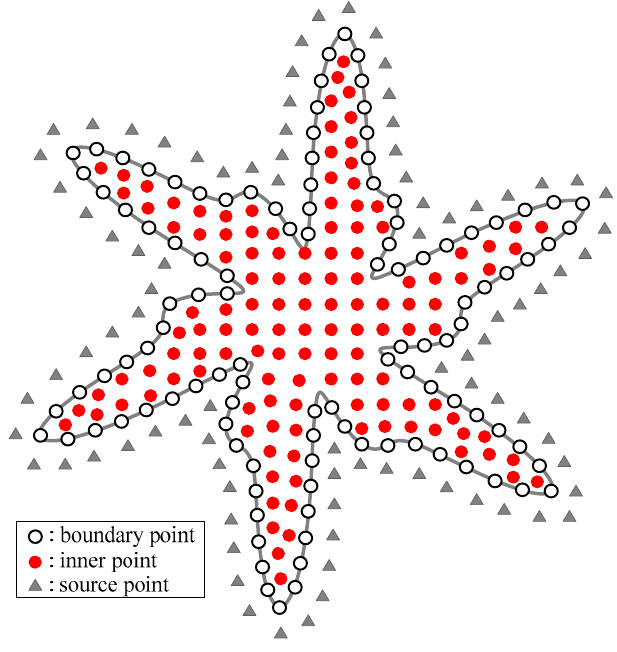
Figure 1. Internal source collocation scheme for the proposed method.